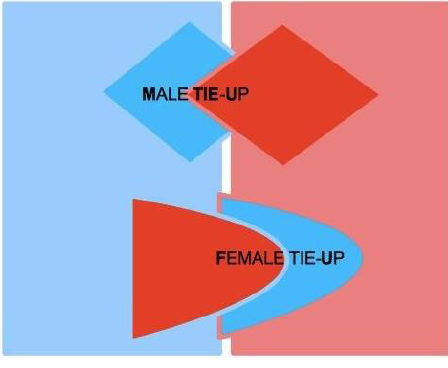
Figure 2. Double Tie-Up.